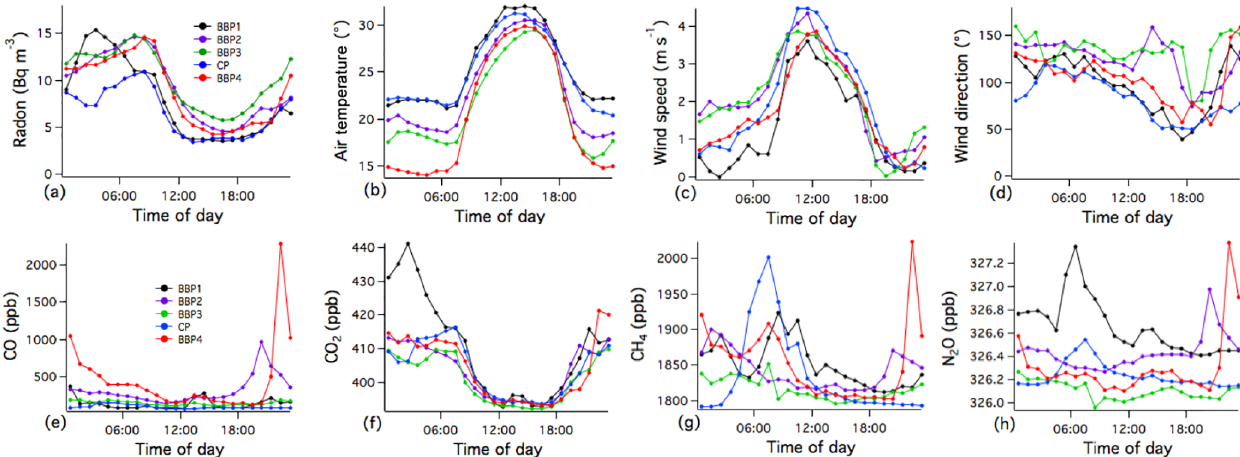
Figure 5. Mean hourly diurnal (a) radon, (b) wind speed, (c) wind direction (d) dew point temperature (e) CO, (c) CO 2 , (d) CH 4 , and (e) N 2 O at ATARS, separated into different biomass burning periods (BBP) and a coastal period (CP). All parts-per notation refers to mole